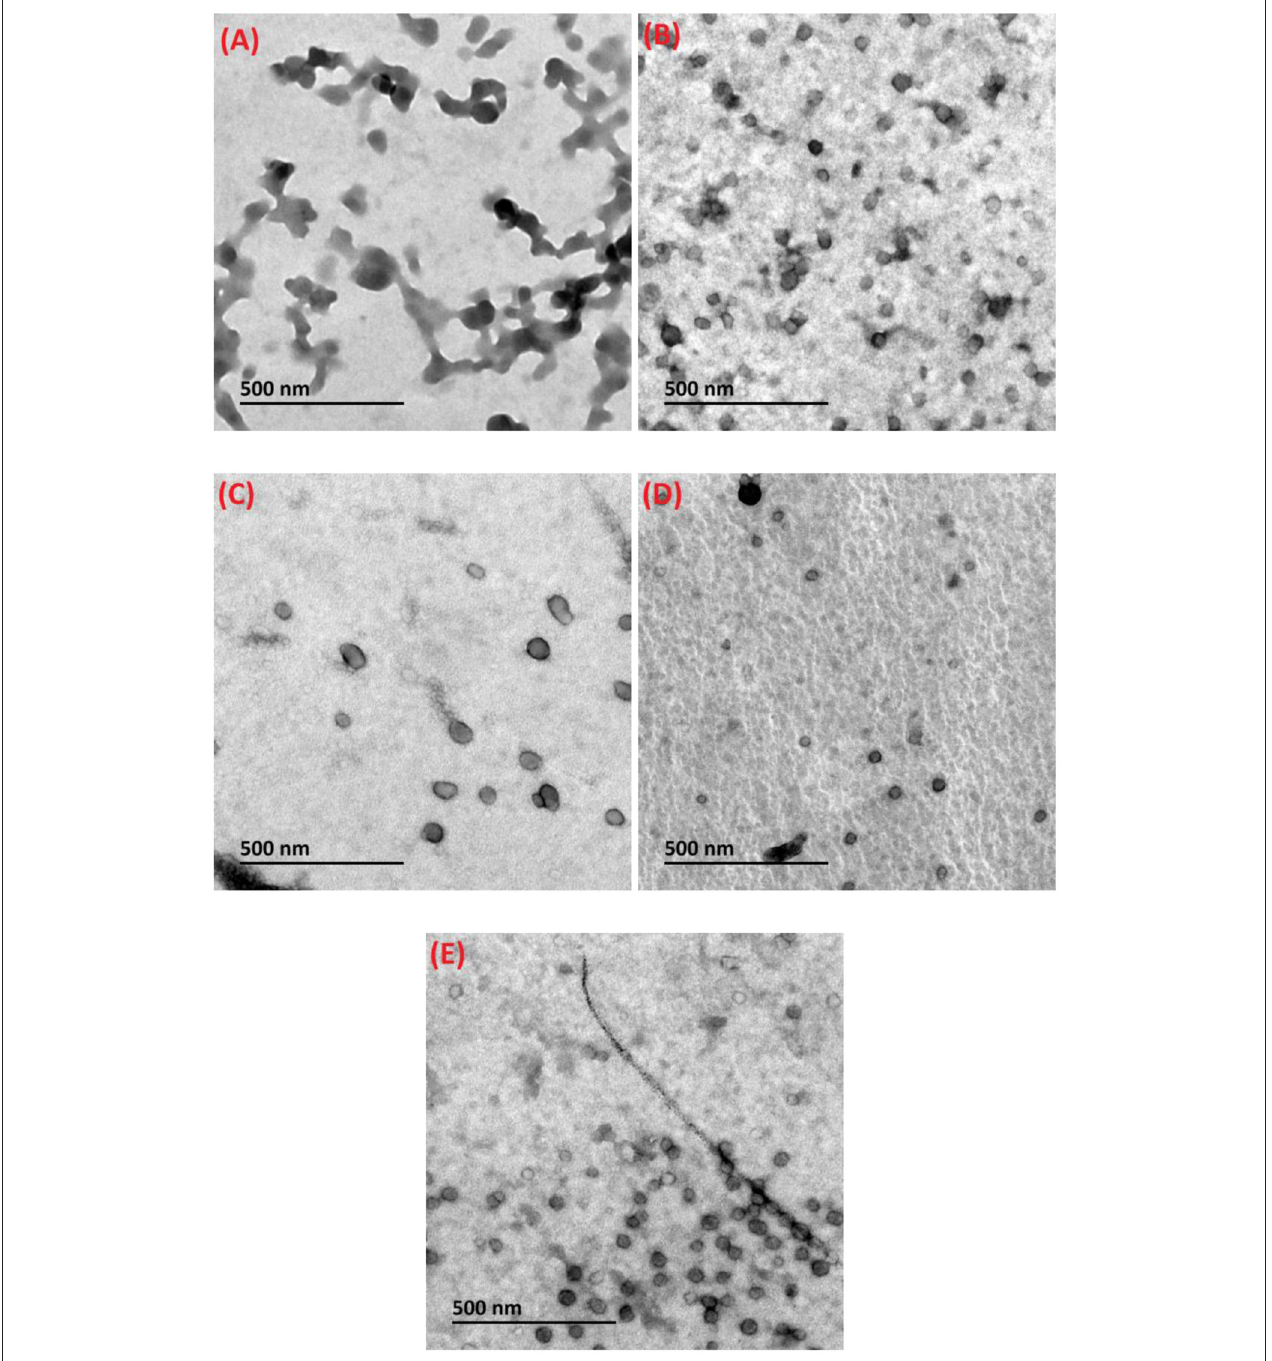
FIGURE 3 | Transmission electron microscopy (TEM) images of dihydroxyflavone (DHF)-zein (A) , DHF-zein/LF (B) , DHF-zein/LF 10K (C) , DHF-zein/LF 40K (D) , and DHF-zein/LF 70K (E) . Pictures were taken at × 50,000